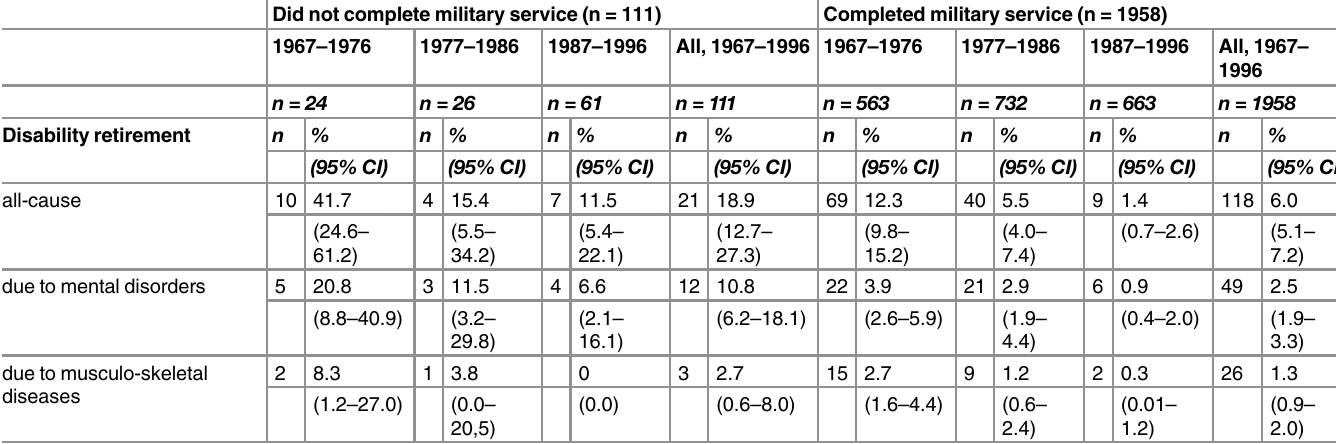
Table 3. Cumulative incidence (%) of disability retirement by completeness of military service, in three service time strata. Did not complete military service (n = 111)